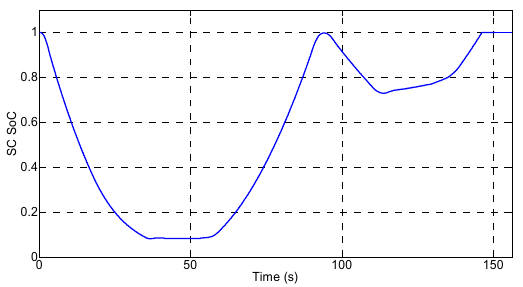
Figure 11. State of charge (SoC) of SC for operating a 40 ‐ ton container.